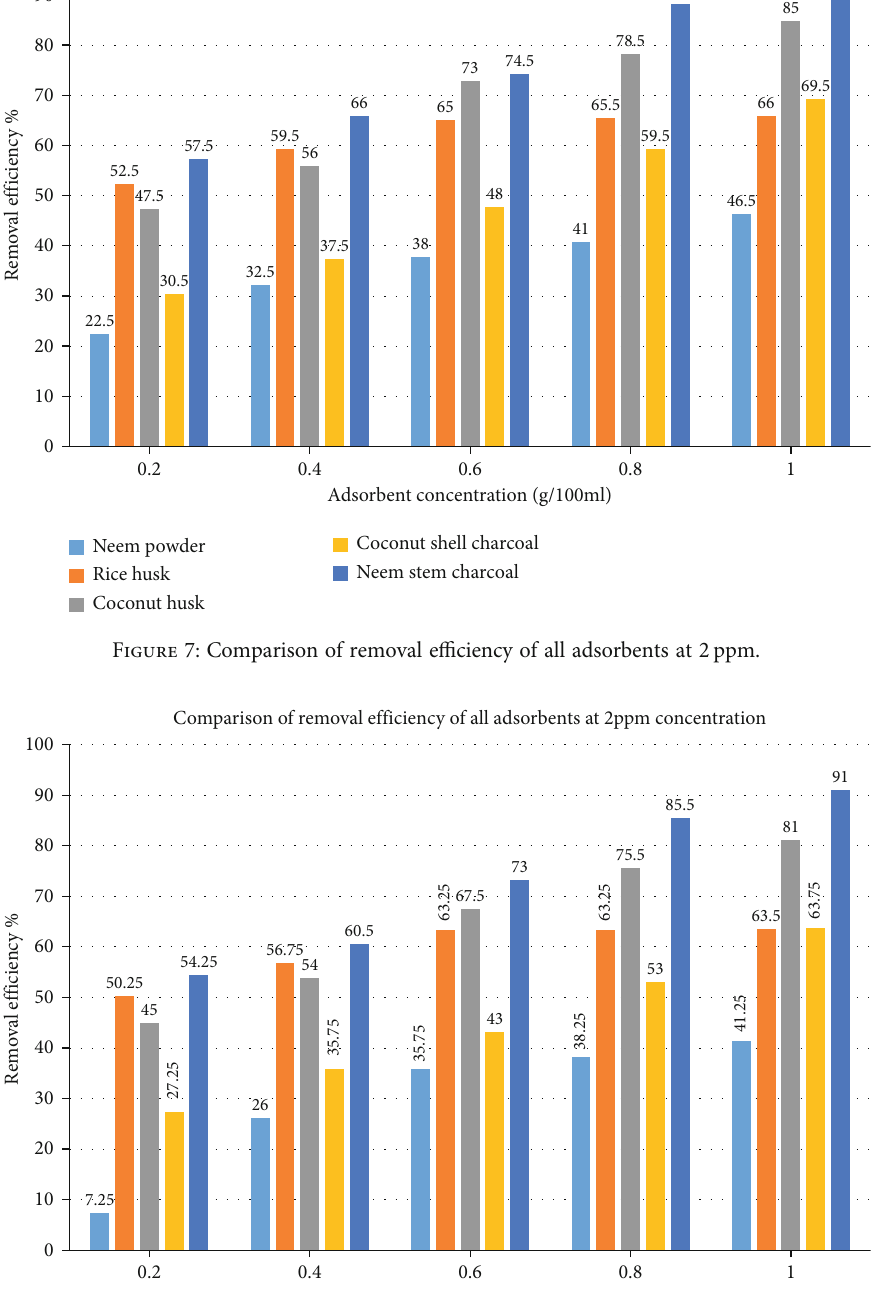
(g/100ml)0 0.2 Adsorbent concentration